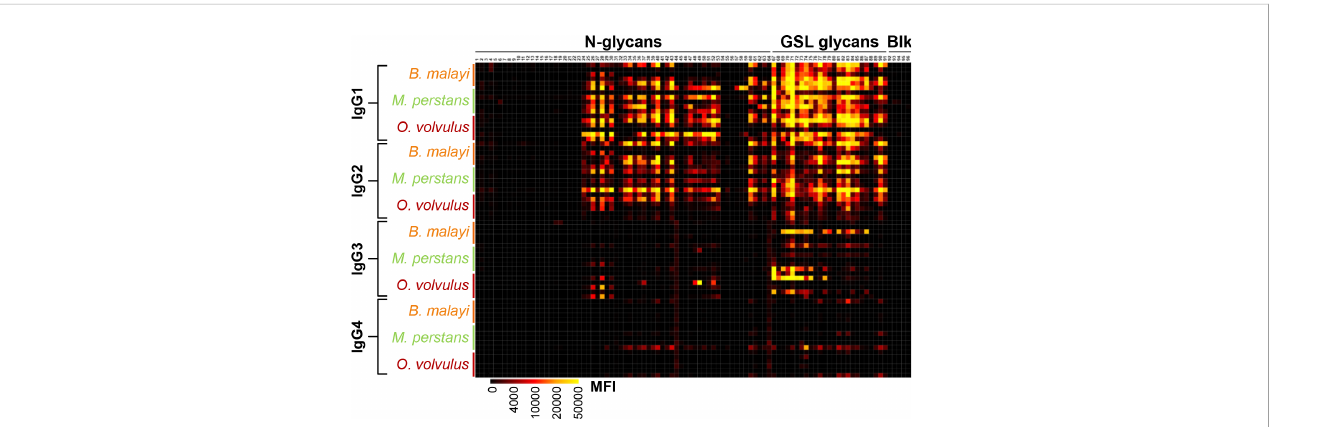
FIGURE 6 IgG subclass responses in plasma from B. malayi- , O. volvulus- and M. perstans- infected individuals to B. malayi glycans. ( B ) malayi glycan microarrays were screened for binding of IgG subclasses with plasma of B. malayi - (n = 5), O. volvulus- (n = 6) and M. perstans- (n = 6) infected individuals. Subclass speci fi c fl uorescent secondary antibodies were used for detection of IgG subclass binding. Heatmap was generated from obtained background corrected MFIs (see intensity key at the bottom) and shows binding of all IgG subclasses for each infected individual as indicated on the Y-axis. X-axis displays the various glycan fractions printed on the array as detailed in (21). Type of fraction content (N-glycan and GSL glycan) or control (Blk) is indicated above the fraction